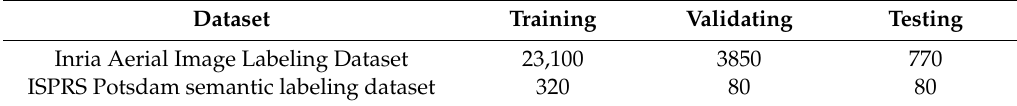
Table 2. The number of samples for training, validating, and testing from the two standard datasets.